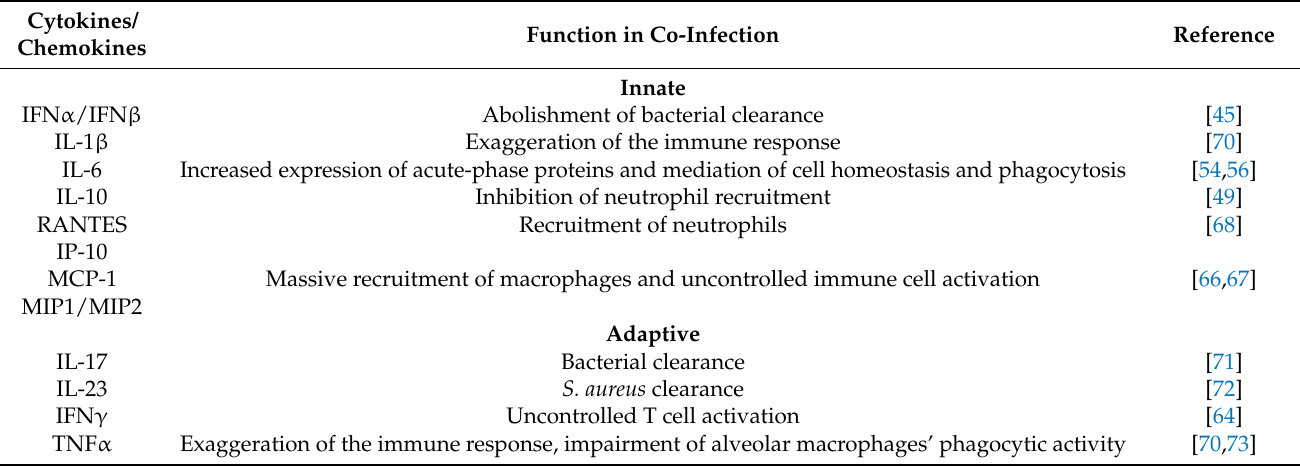
Table 1. List of cytokines and chemokines induced and their roles in influenza virus and S. pneumoniae or S. aureus